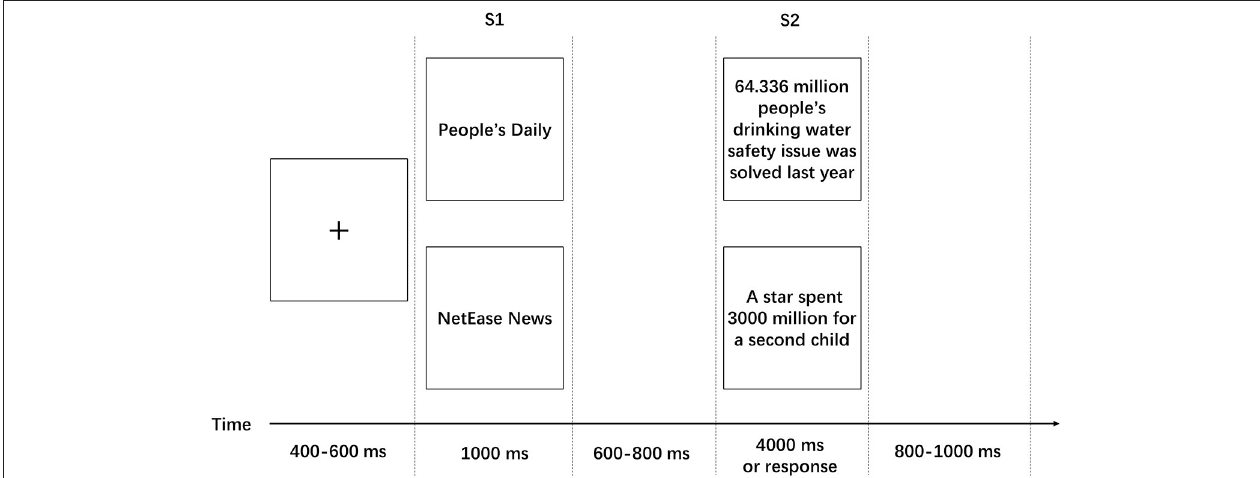
FIGURE 2 | Single trial of the experimental procedure: Participants first observed either a new media channel or a traditional media channel before the presentation of a hard news or soft news item. They were asked to press a button to indicate whether or not they would trust the news presented in 4,000ms. Participants’ electroencephalograms (EEGs) were recorded throughout the